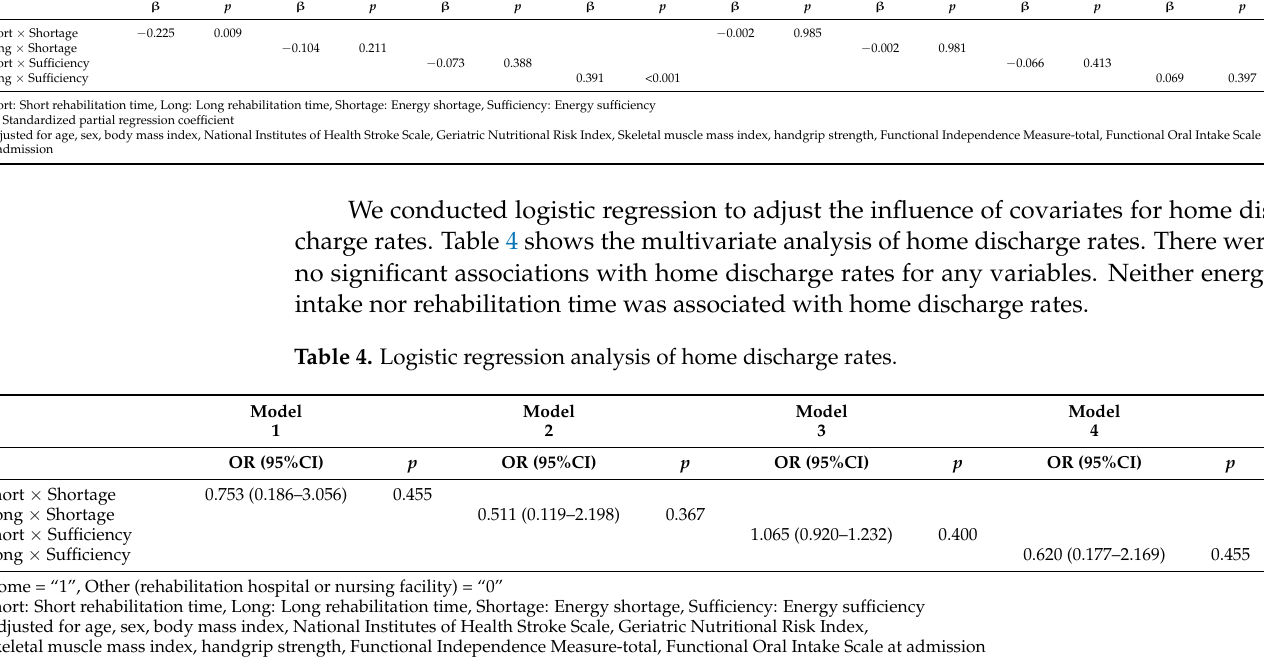
Table 4. Logistic regression analysis of home discharge rates.